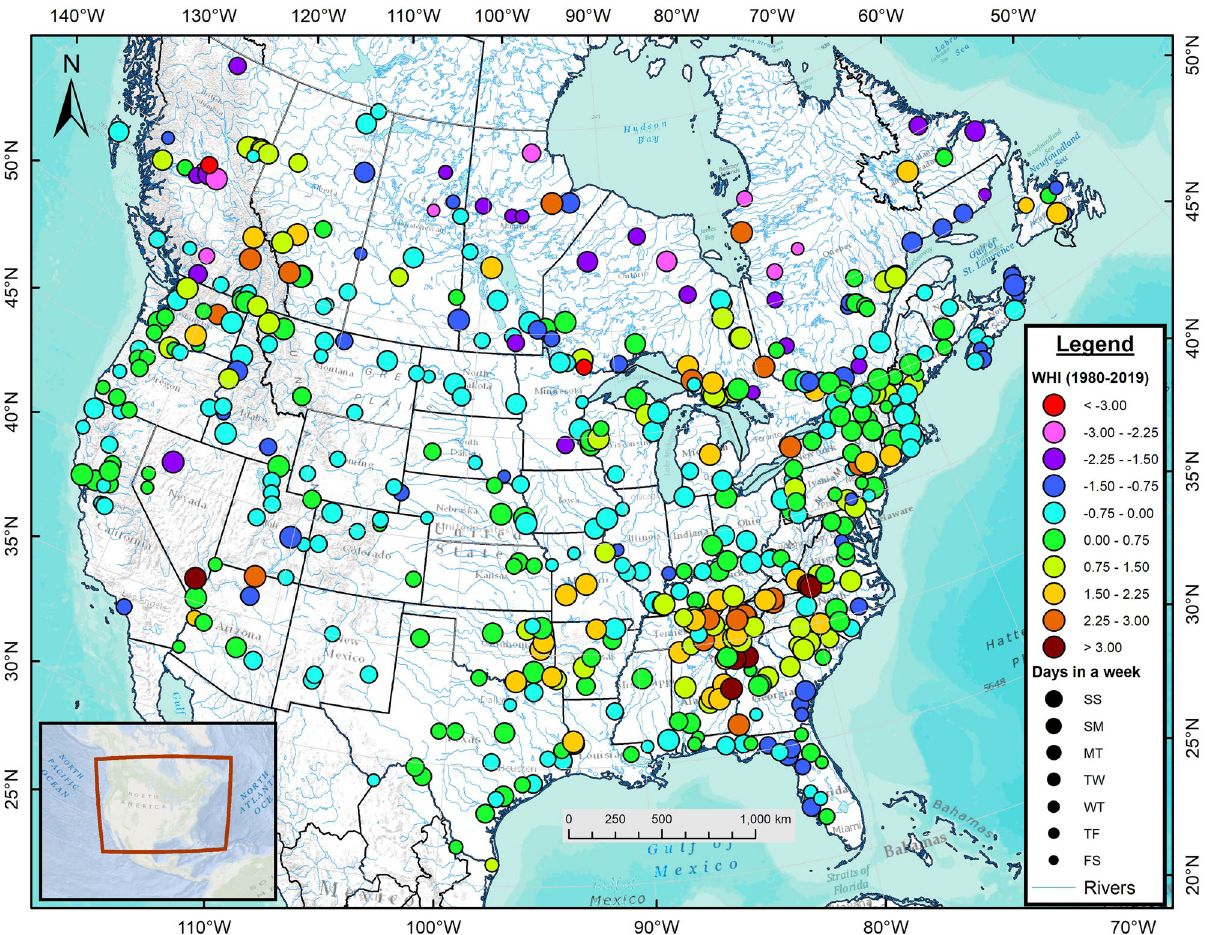
Fig. 1 Map of the 1980 – 2019 mean WHI values for 500 sites across the USA and Canada. Circle size corresponds to the two consecutive days with low fl ows beginning with the Saturday/Sunday (SS, largest symbols) combination and ending with the Friday/Saturday (FS, smallest